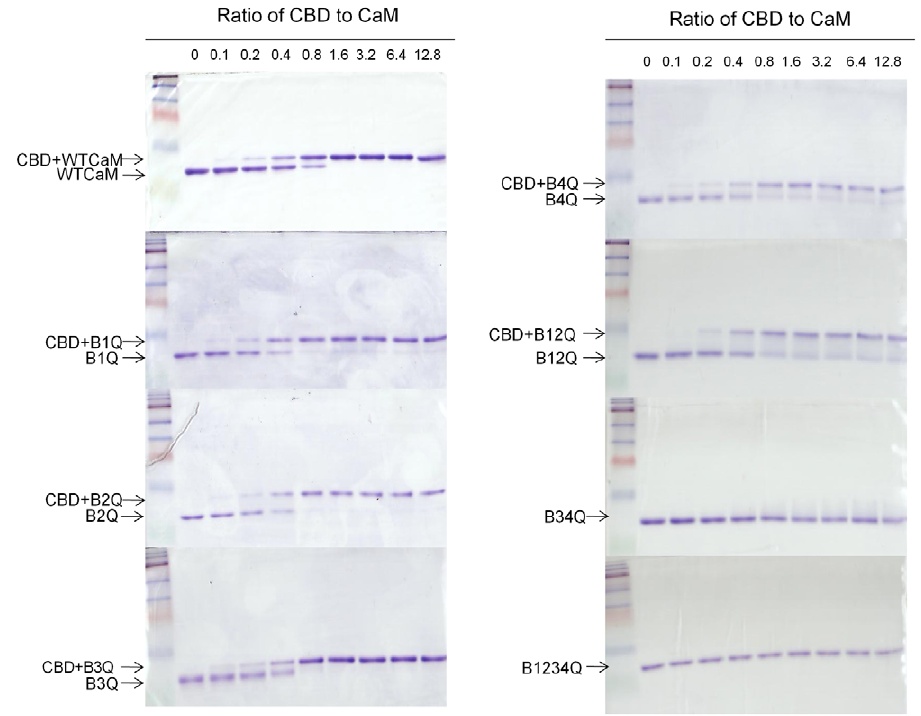
Figure 4. Interaction of CaM-binding domain with each CaM construct. The canonical CaM-binding domain of human eNOS (CBD, residues 491–510) was incubated with CaM constructs (200 pmol) by increasing peptide:CaM molar ratios at room temperature for 1 h before electrophoresis in the presence of 100 m M of calcium. The samples were analyzed on 18% non-denaturing gels and visualized with Coomassie Blue R-250. The first lane in each gel contains CaM only, i.e. CBD/CaM ratio is 0. The rest CBD/CaM ratios were indicated. CBD-CaM complexes and free CaM are denoted.